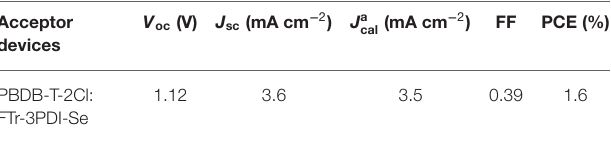
TABLE 1 | Photovoltaic parameters of OSCs based on PBDB-T-2Cl: FTr-3PDI-Se under AM1.5G illumination at 100 mW cm − 2 . Acceptor devices